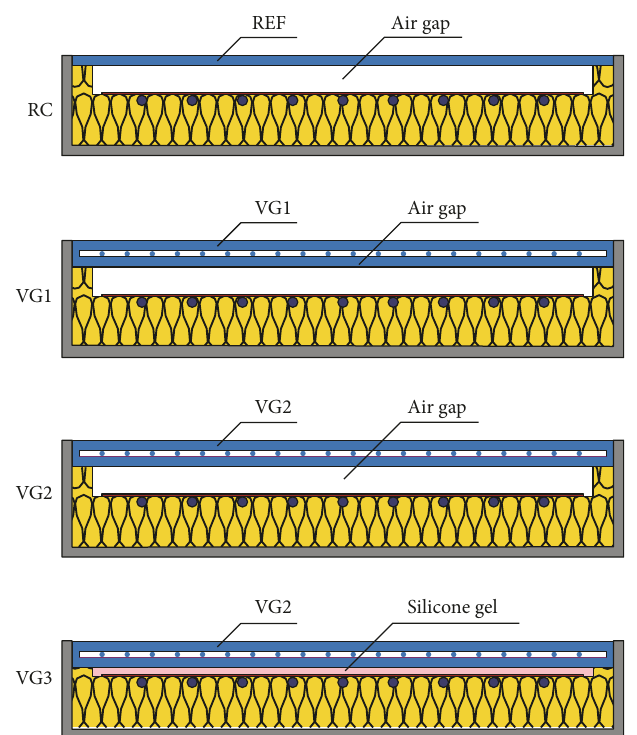
Figure 7: Considered solar collector con fi gurations.